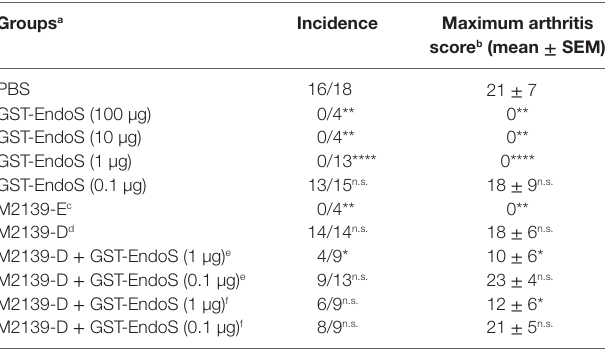
TaBle 3 | Titration of inhibitory dose of endo- β - N -acetylglucosaminidase (EndoS) using antibody-mediated inflammation. groups